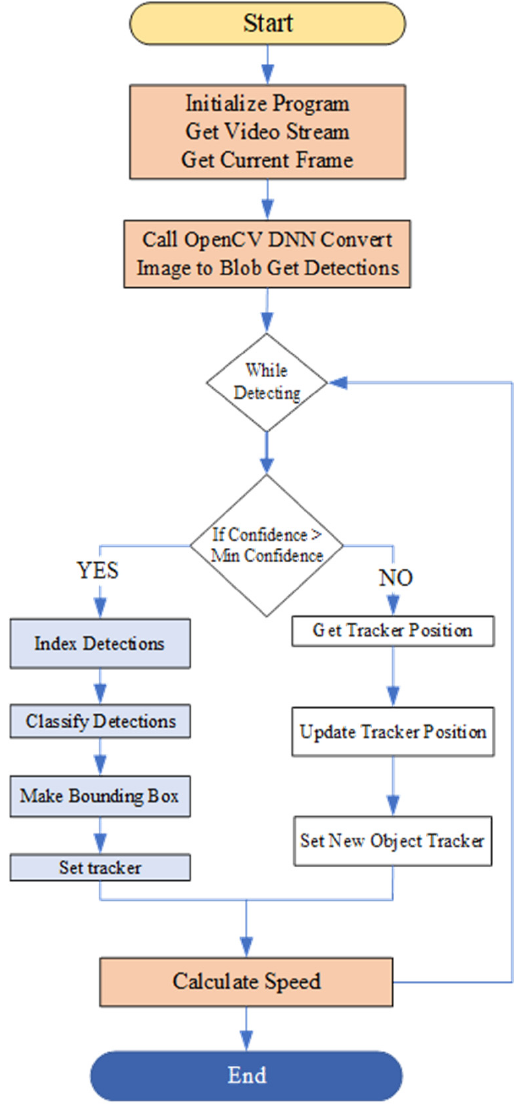
Figure 3. The proposed vehicle speed estimation process.